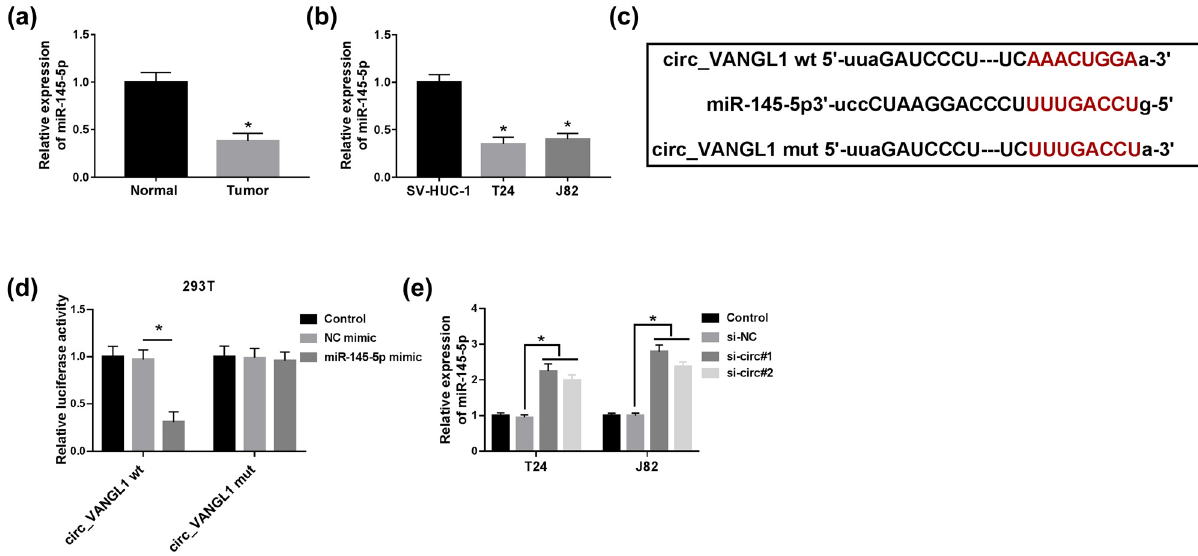
Figure 3: miR - 145 - 5p was a target of circ_VANGL1. ( a and b ) RT - qPCR was used to detect the level of miR - 145 - 5p in bladder cancer tissues ( n = 36 ) and cells. ( c ) Schematic of the putative or mutant binding sites of miR - 145 - 5p in circ_VANGL1 that predicted by starBase v2.0 tool. ( d ) The luciferase activity in 293T cells co - transfected with miR - 145 - 5p mimic or NC - mimic and circ_VANGL1 wt or circ_VANGL1 mut. ( e ) T24 and J82 cells were transfected with si - NC, si - circ#1, or si - circ#2, respectively. And the expression level of miR - 145 - 5p was examined by RT - qPCR. * P <